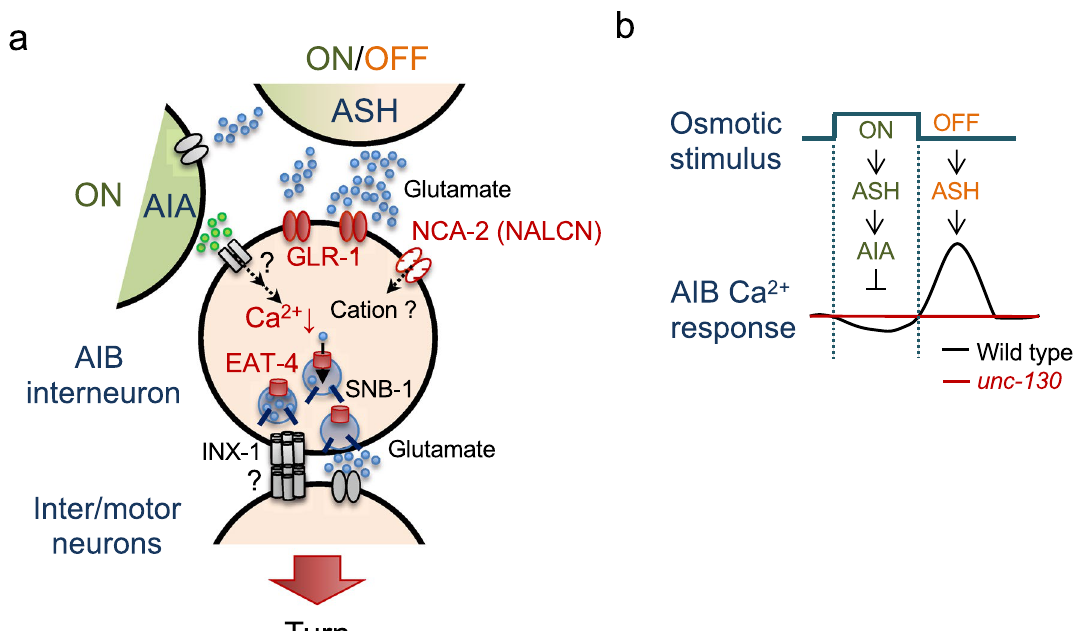
Figure 6. Schematic model of the AIB calcium response regulated by unc-130 . ( a ) Relationship between the ON/OFF stimulus and calcium dynamics in AIB. During stimulation, excitatory/inhibitory (E/I) balance from ASHs and AIAs could bias inhibition, leading to ON responses (calcium decreases) in AIBs. After stimulation, the ASH OFF response (calcium increase) is a possible trigger for the OFF response (calcium increase) in the AIBs. unc-130 impaired both ON responses and OFF responses (red line). ( b ) Schematic of the molecules used for optimization and the contribution of unc-130 (shown in red). unc-130 is necessary for the